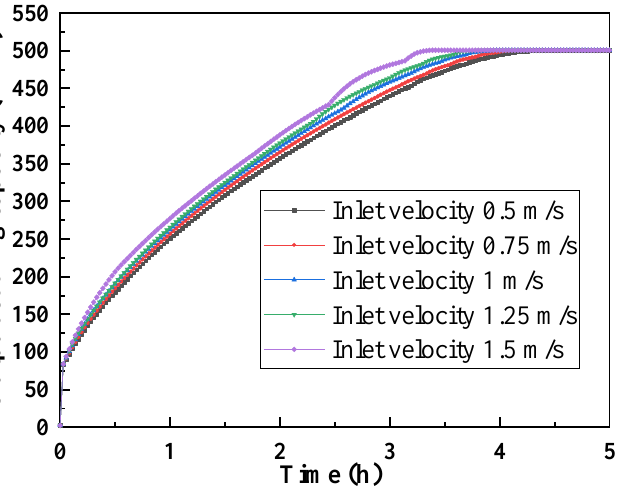
Figure 14. Variation of the output cooling capacity for the external ice melting device under different fed water velocities from the main pipe inlet.